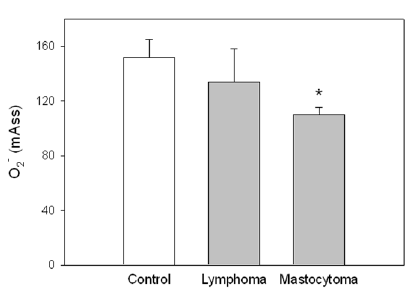
Figure 1. Superoxide anion (O 2 •− ) levels expressed as milliabsorbance units (mAbs). Healthy dogs (control, n = 24), multicentric lymphoma (lymphoma, n = 11), primary cutaneous MCT (mastocytoma, n = 14). * p < 0.05 vs. control.